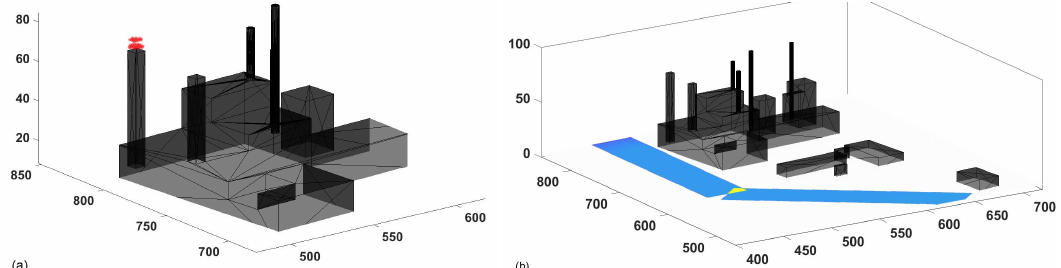
Figure 6. ( a ) Emitting cells in red for the point sources; ( b ) linear sources emitting cells inside the